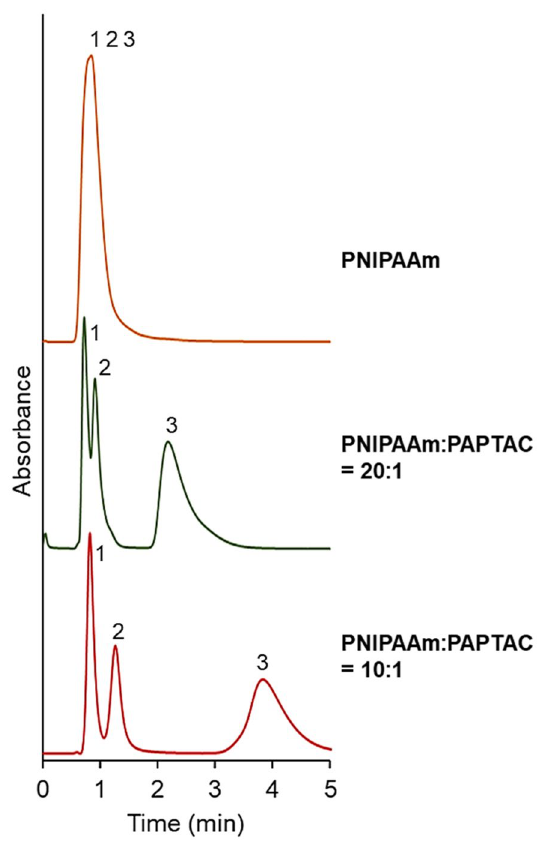
Figure 4. Chromatograms of adenosine nucleotides using prepared mixed-mode columns. The mobile phase is 33.3 mmol/L phosphate buffer solution (pH = 7.0). The flow rate of the mobile phase is 1.0 mL/min, and detection was measured at a wavelength of 260 nm. The column temperature is 40 °C. Peak 1 = AMP, peak 2 = ADP, and peak 3 = ATP. (Figures were drawn Microsoft PowerPoint 2019 Version